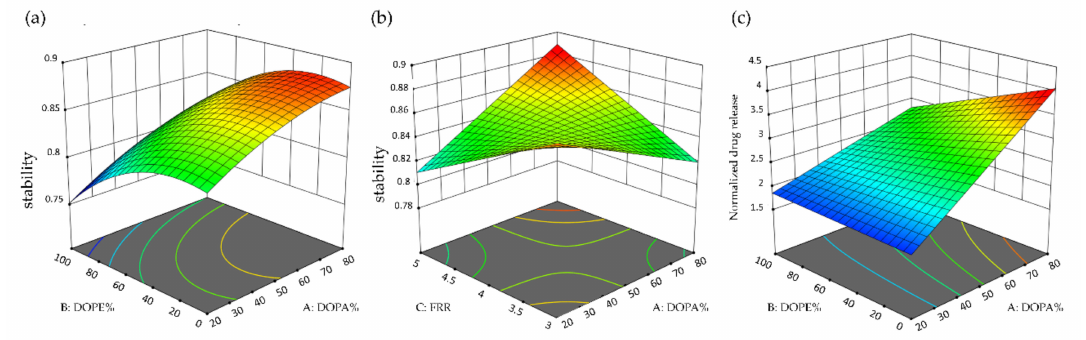
Figure 9. 3D surface plot for ( a ) the interaction of DOPA% and DOPE% with stability, ( b ) the interaction of DOPA% and FRR with stability, and ( c ) the interaction of DOPA% and DOPE% with normalized drug